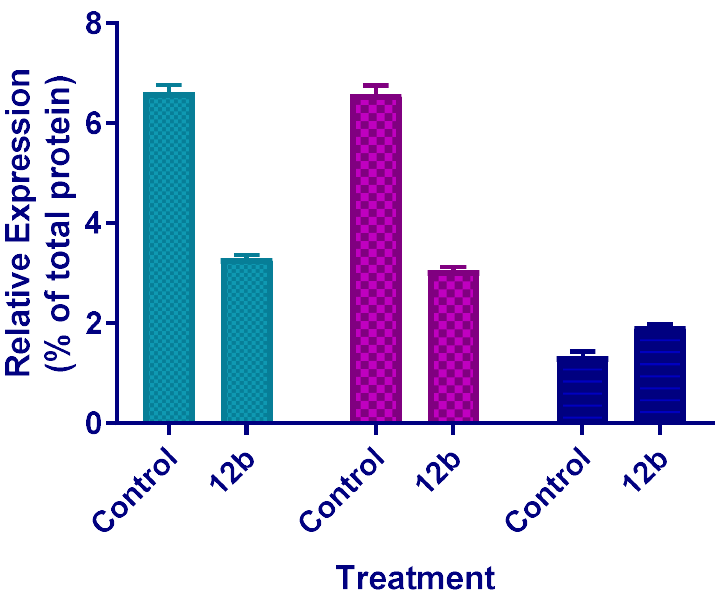
Figure 12. Relative expression of p38, MKK3, and JNK in 12b -treated HepG-2 cells. Figure 12 . Relative expression of p38, MKK3, and JNK in 12b -treated HepG-2 cells.